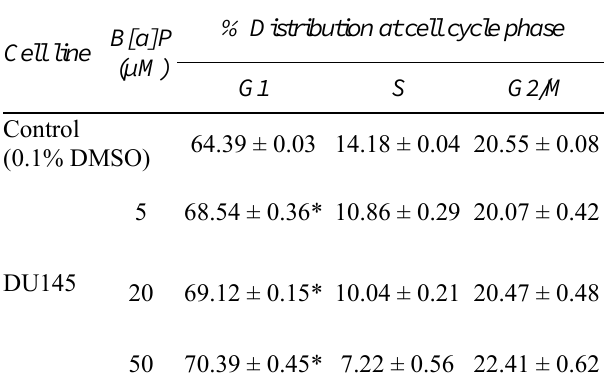
Table 1 : The cell cycle distribution of DU145 after 48 h treatment with varying concentrations of B[a]P. Data presented are means & SDs of three independent investigated experiments. Mean values of three replicates were analyzed for significant differences between treatments and control with one-way ANOVA.